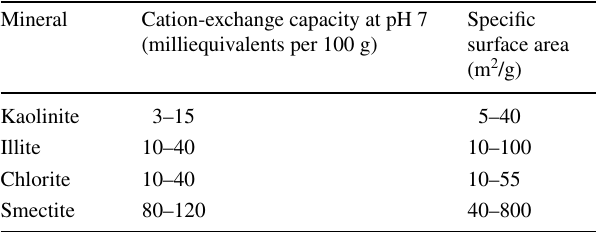
Table 2 Cation-exchange capacities and specific surface areas of clay minerals